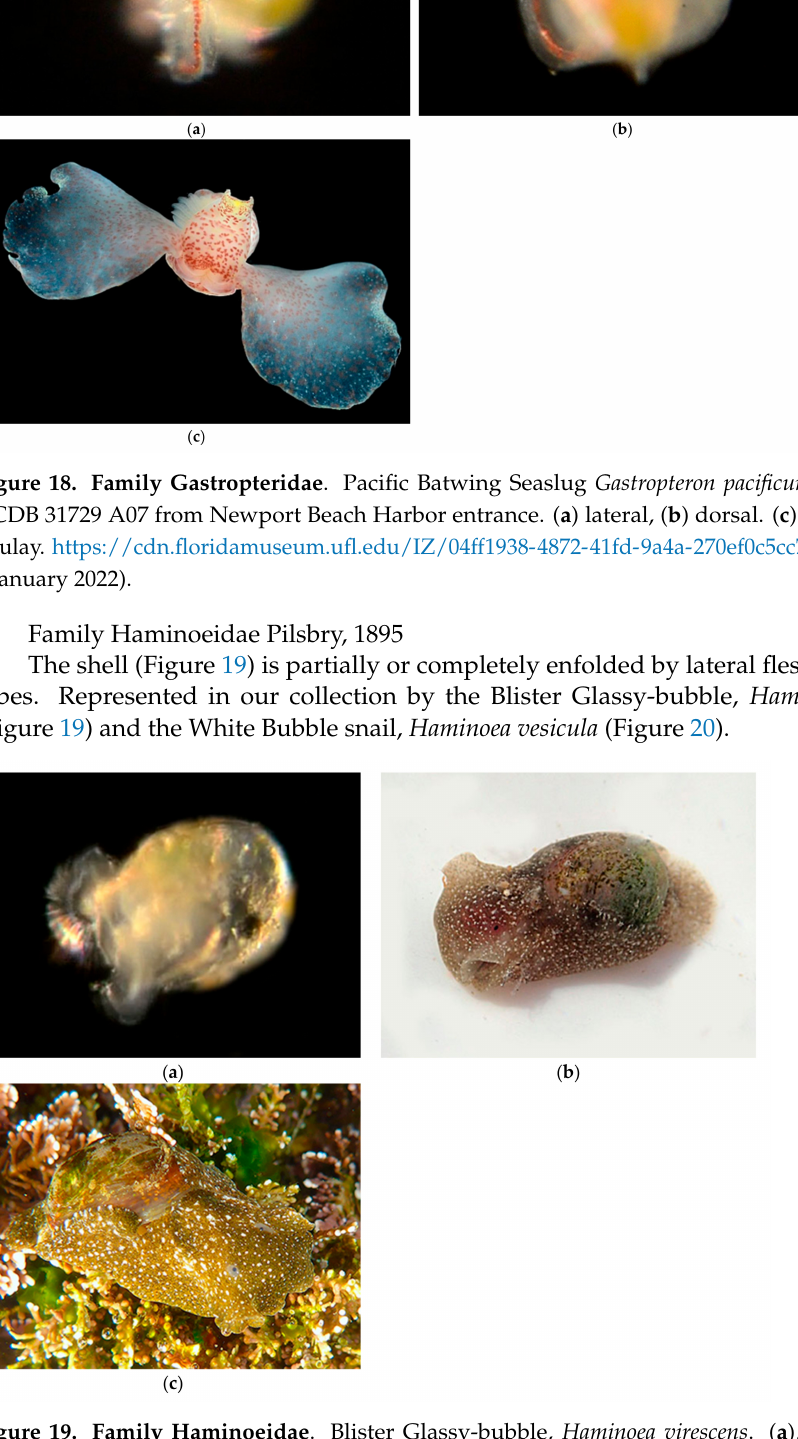
Figure 19. Family Haminoeidae . Blister Glassy-bubble, Haminoea virescens . ( a ), Veliger CCDB- 24722-G10 from Balboa at Coral. ( b ), Adult CCDB-24002-D05 from Shaw’s Cove south. ( c ), Adult CCDB-31729 B02 from Twin Points, Crystal Cove State